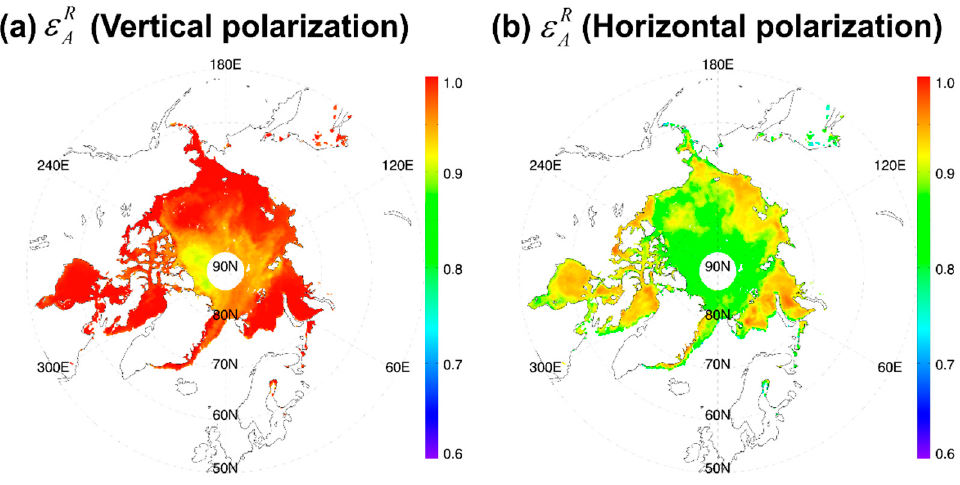
Figure 4. Geographical distributions of the obtained apparent emissivities based on CF R for ( a ) vertical and ( b ) horizontal polarizations at 19.4 GHz on 1 January 2004.